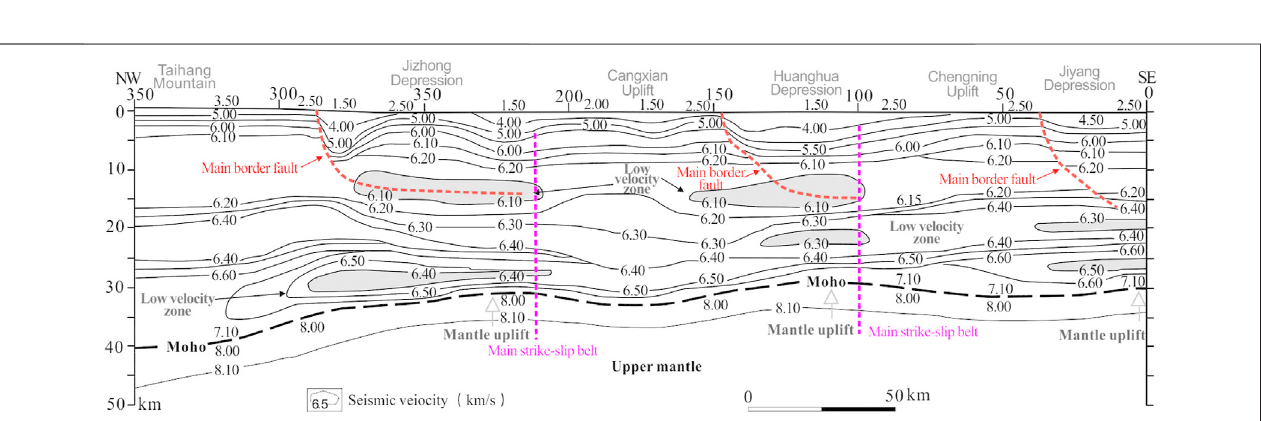
FIGURE 8 | Sectional view of the deep structure in North China (according to Liu et al., 1984).